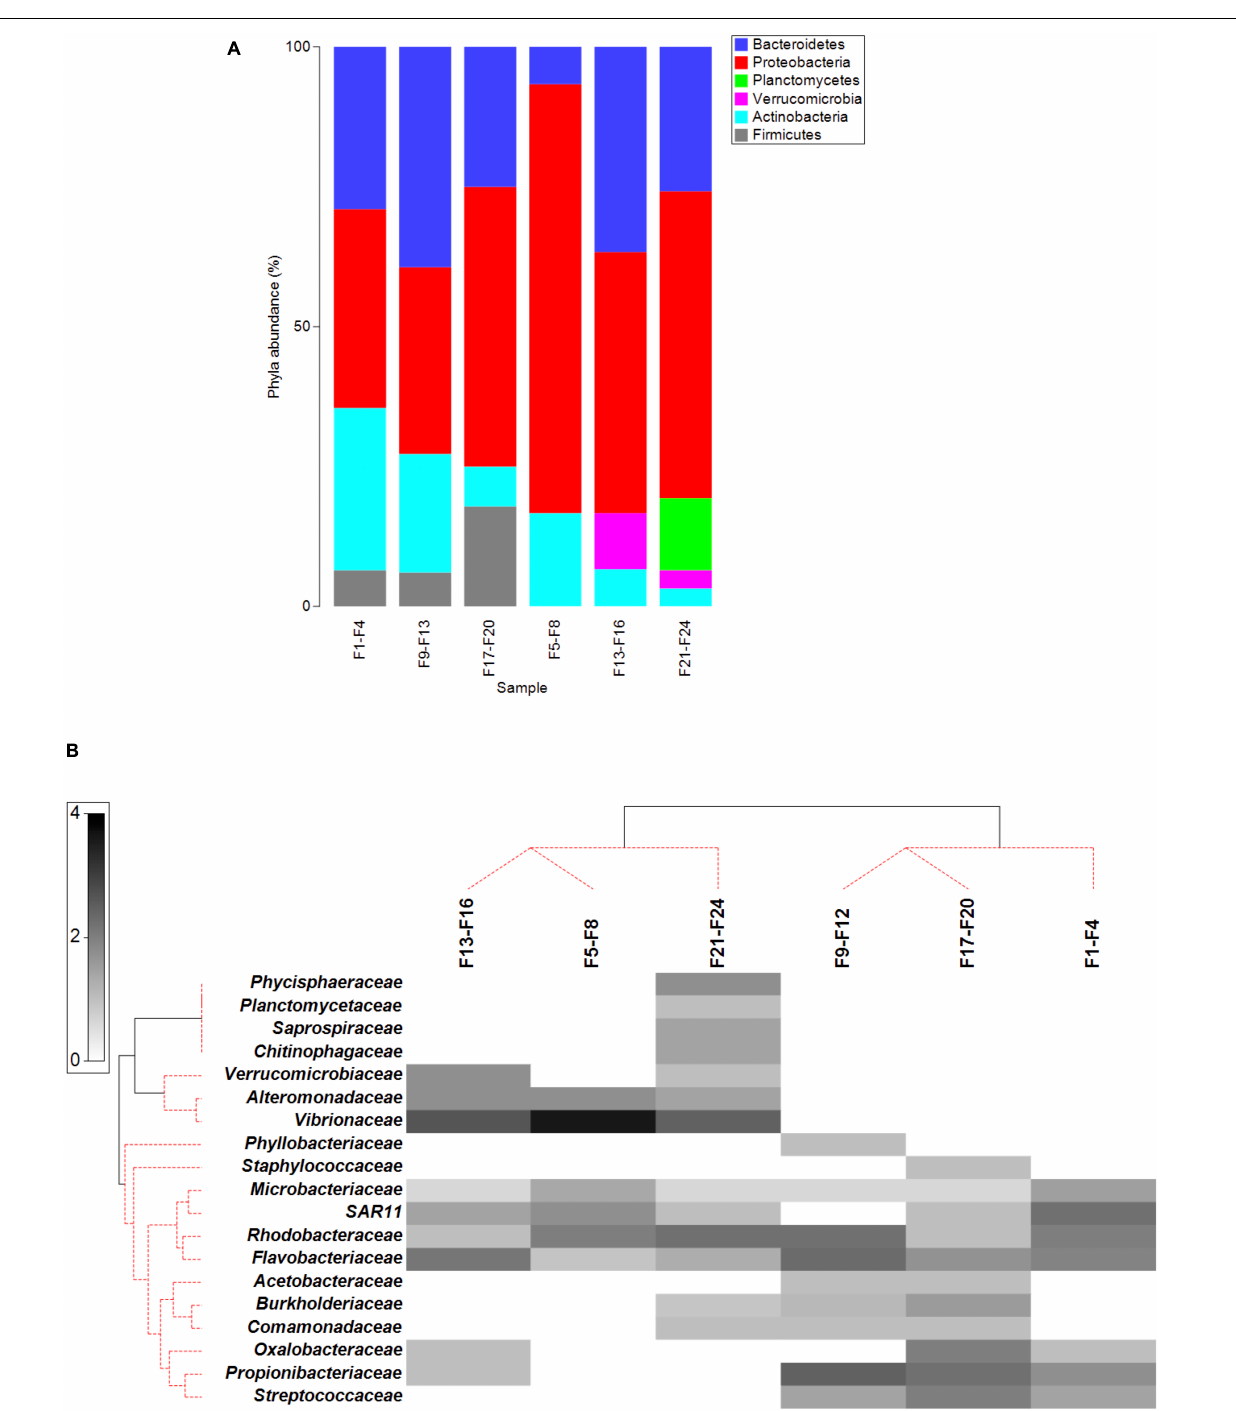
Frontiers in Physiology |